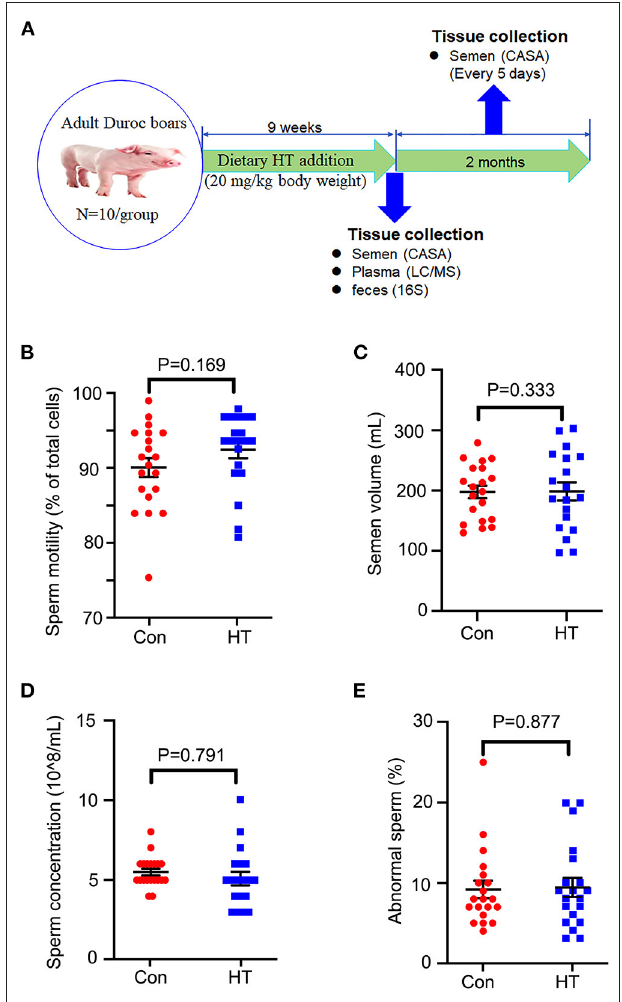
FIGURE 1 | Effects of HT on the semen quality. (A) Study design. (B) Sperm motility. (C) Semen volume. (D) Sperm concentration. (E) Abnormal sperm. Data were expressed as the mean ±